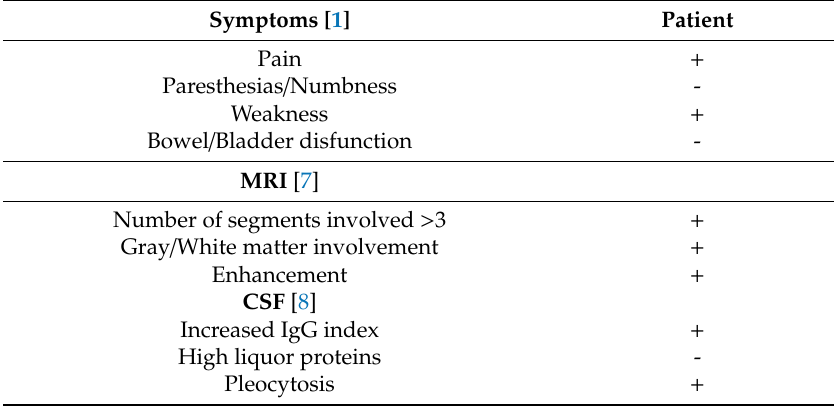
Table 1. Symptoms and findings in our